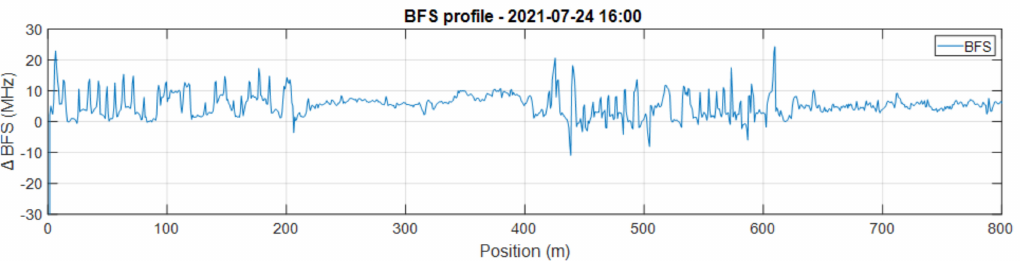
Figure 9. An example of BFS profile from the entire D-FOS system. Each loop installed is about 200 m long.